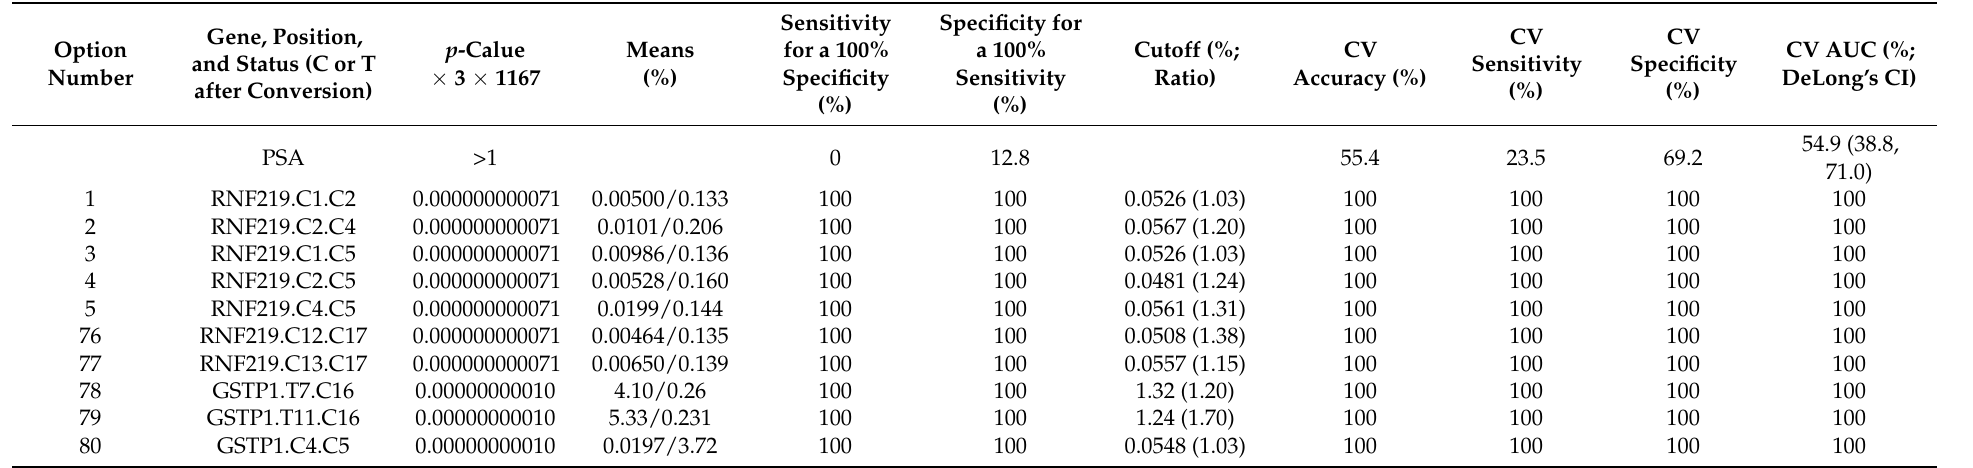
Table 5. Comparison of BPH patients with the joint group including HD and PCa patients.